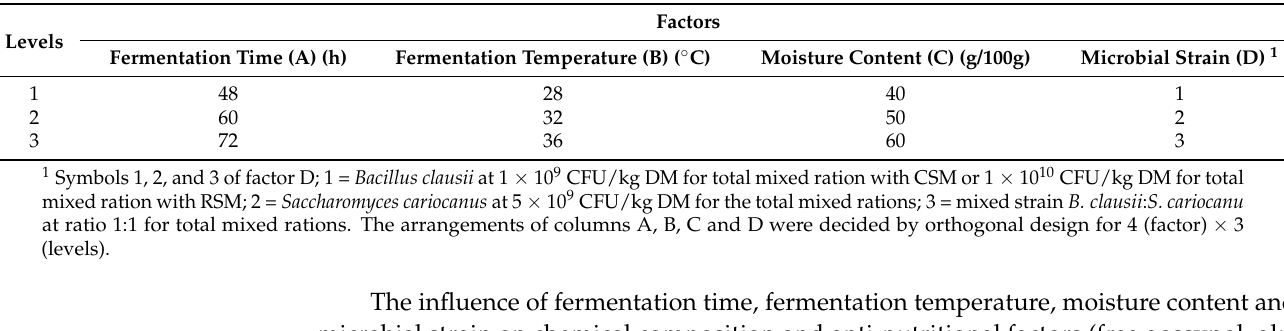
Table 1. Factors and levels selected for optimum fermentation conditions of orthogonal design.